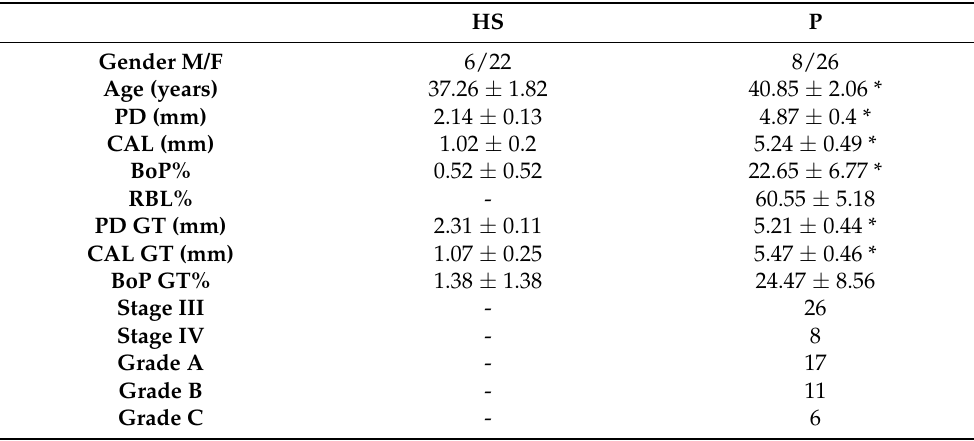
The results are expressed as mean and standard error or percentage. HS: Healthy Subjects, P: Periodontitis, M: Male, F = Female, PD: Probing depth, CAL: Clinical Attachment loss, BoP%: Bleeding of Probing